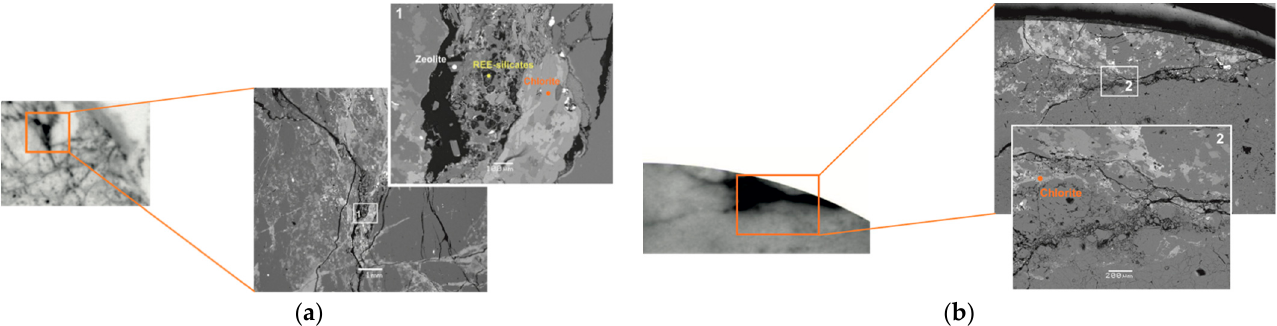
Figure 6. Cesium ( a ) and strontium ( b ) distribution in the fracture zone of R-11 sample (radiogram on the left, SEM images on the right); Chl—chlorite phase (the main filler of cracks).